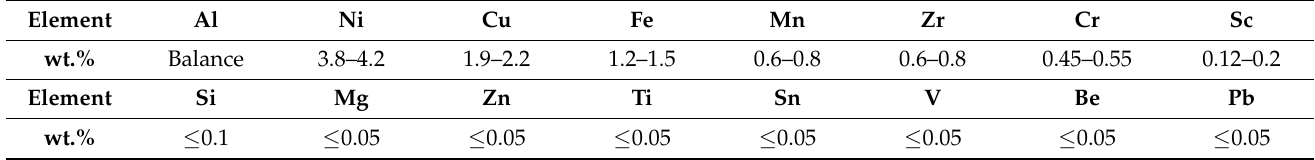
Table 2. Composition of the SLM Al-Ni-Cu alloy